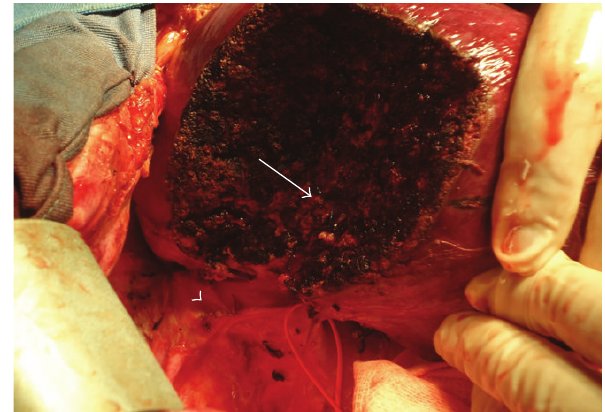
Figure 4: Final aspect of surgery. Divided RHV (arrow head) and portal pedicle (arrow) can be